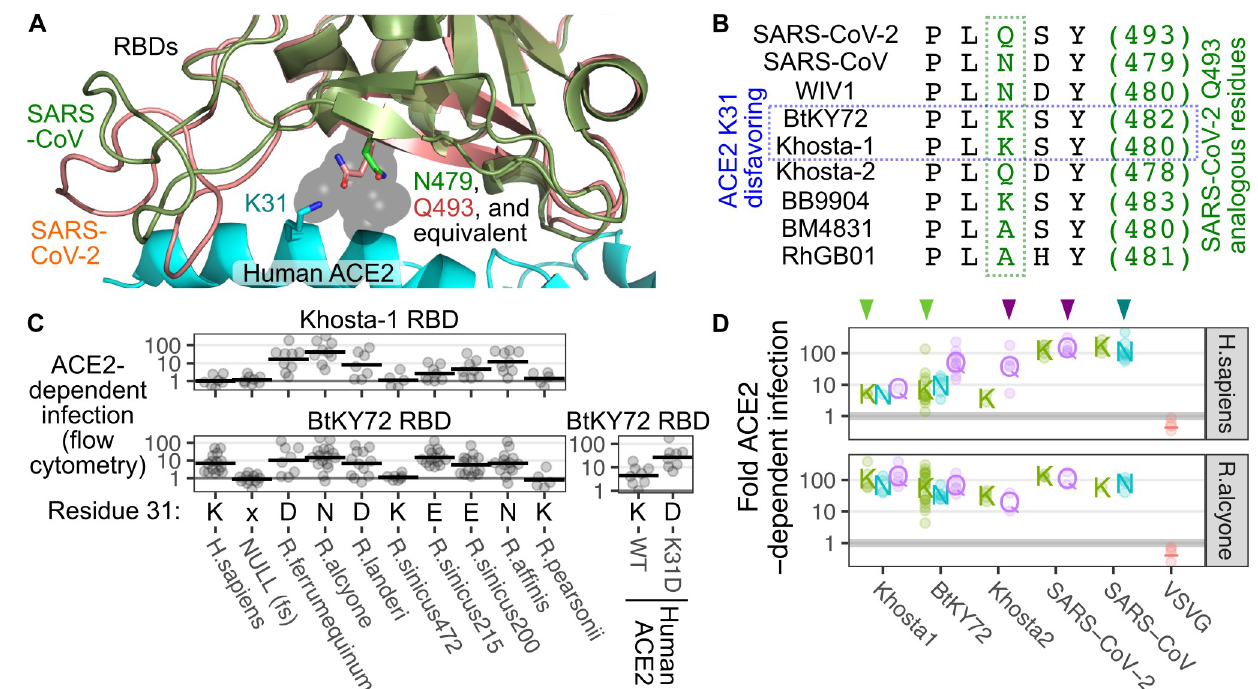
Fig 7. Impacts of ACE2 residue 31 on BtKY72 and Khosta-1 binding. (A) The SARS-CoV-2 RBD (salmon, pdb: 6m17), SARS-CoV RBD (green, pdb: 3sci), and human ACE2 (cyan; pdb: 6m17) interface. The K31 residue on human ACE2, the Q493 residue of the SARS-CoV-2 spike, and N479 residue of SARS-CoV spike are shown as sticks. Side chain atoms from the homology models equivalent to SARS-CoV-2 spike Q493 and SARS-CoV N579 are shown as semitransparent gray spheres. (B) Alignments of RBD residues including and adjacent to SARS-CoV-2 spike Q493, which extends from a conserved beta-strand and interacts with position 31 on ACE2 as shown in panel A. (C) Comparison of patterns in ACE2 ortholog usage for BtKY72 and the side chain present in ACE2 position 31. (D) Khosta-1 and BtKY72 RBDs naturally encoding K at the interface position were mutated to Q or N, while SARS-CoV, SARS-CoV-2, and Khosta-2 interface positions were mutated to K, and the ACE2-dependent infectivities were measured on cells expressing human or R . alcyone ACE2. Triangles above the plots denote WT residues for each RBD. VSVG is shown for comparison, with the gray line denoting an ACE2 dependence ratio of 1. Human TMPRSS2 was stably expressed in these cells. The underlying data can be found in S2 Data, and the source code can be found at https://github.com/MatreyekLab/ACE2_dependence. ACE2, angiotensin converting enzyme-2; RBD, receptor binding domain; SARS-CoV, Severe Acute Respiratory Syndrome-related Coronavirus; SARS-CoV-2, Severe Acute Respiratory Syndrome-related Coronavirus 2; VSVG, vesicular stomatitis virus glycoprotein; WT, wild-type.